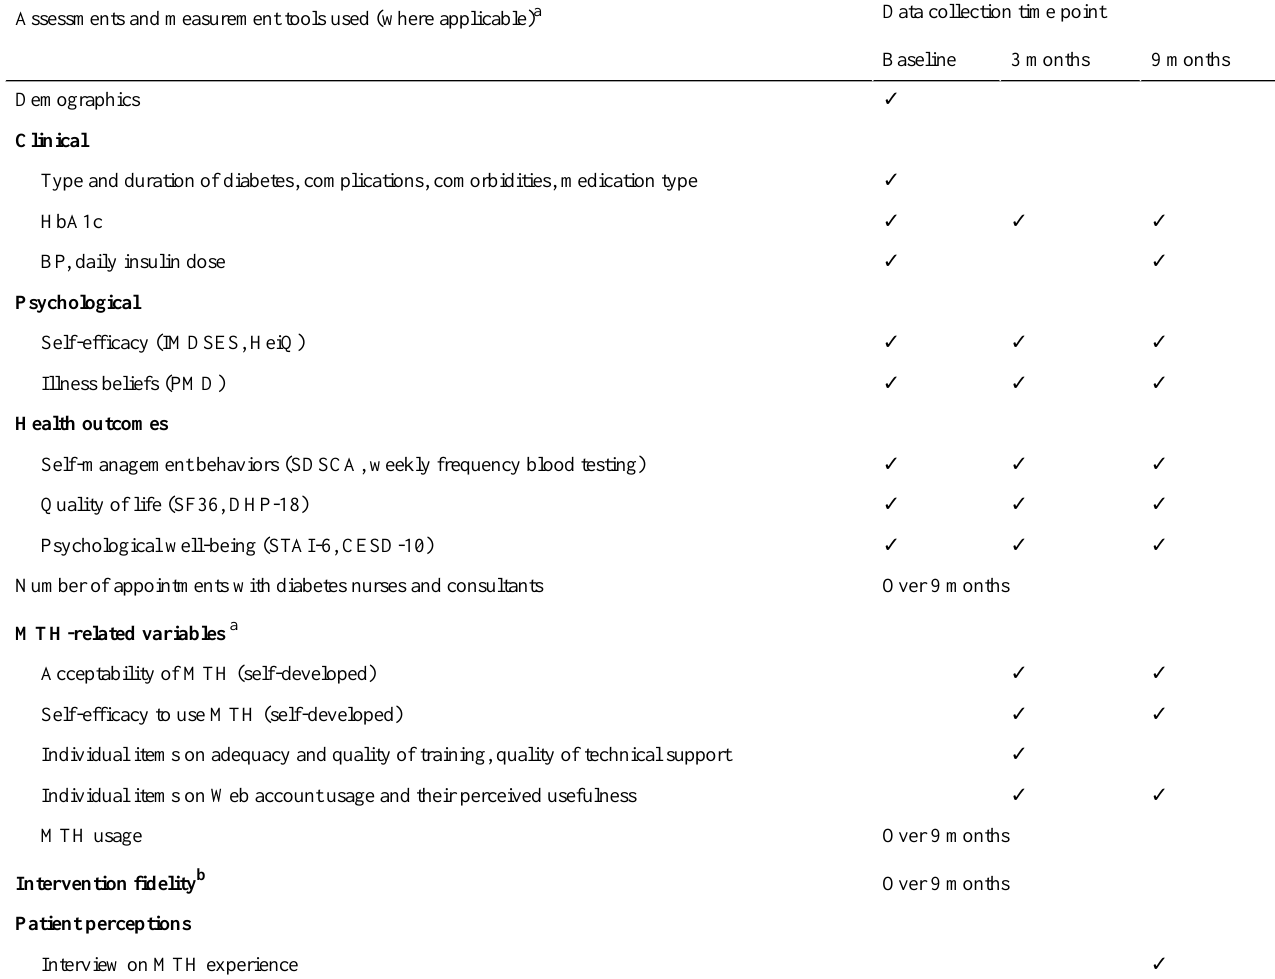
Table 1. Assessment protocol and data collected at the three time points.